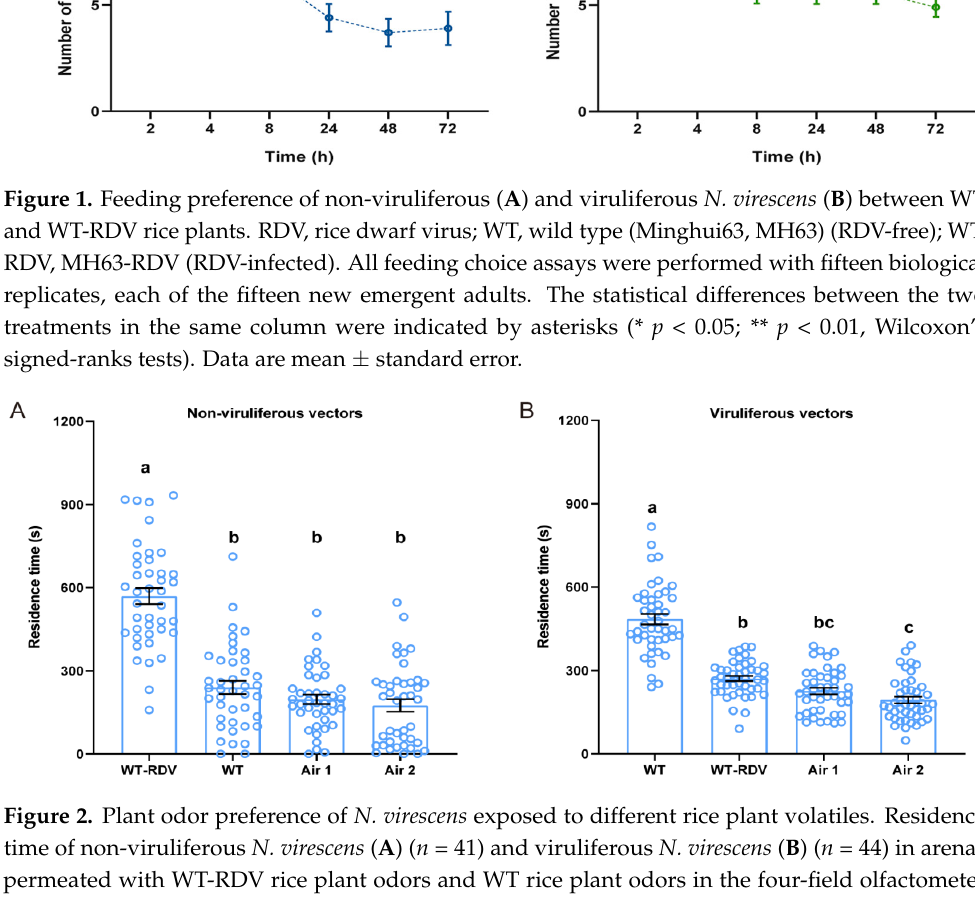
Figure 2. Plant odor preference of N. virescens exposed to different rice plant volatiles. Residence time of non-viruliferous N. virescens ( A ) ( n = 41) and viruliferous N. virescens ( B ) ( n = 44) in arenas permeated with WT-RDV rice plant odors and WT rice plant odors in the four-field olfactometer during the entire test time (1200 s). RDV, rice dwarf virus; WT, wild type (Minghui63, MH63) (RDV- free); WT-RDV, (MH63-RDV) (RDV-infected). WT-RDV, RDV-infected plant odors; WT, RDV-free plant odors; Air1, clean air; Air2, clean air. Deviations from equal distribution were analyzed with a Friedman–ANOVA ( p < 0.05). Bars annotated with different letters are significantly different from each other (Wilcoxon–Wilcox test). Data are mean ± standard